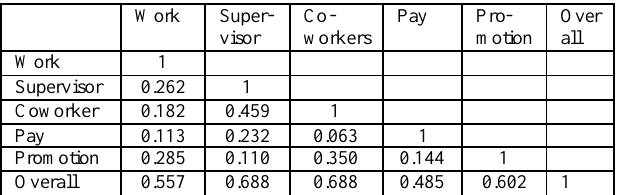
Table 2: Pearson Correlation